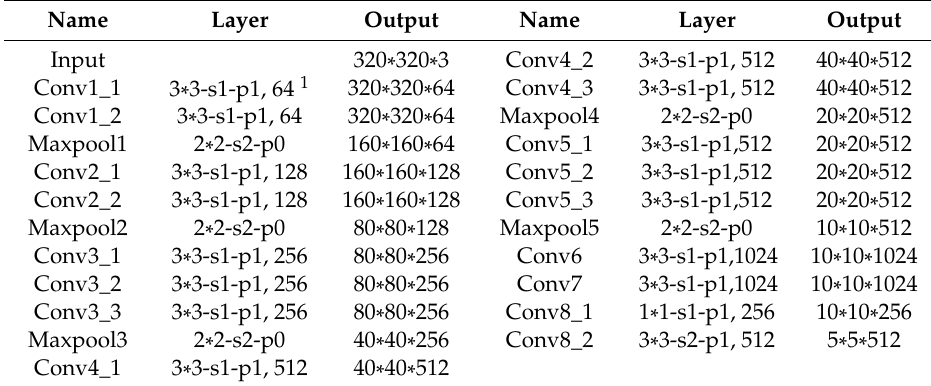
Table 1. The configuration of the VGG-16 based backbone network